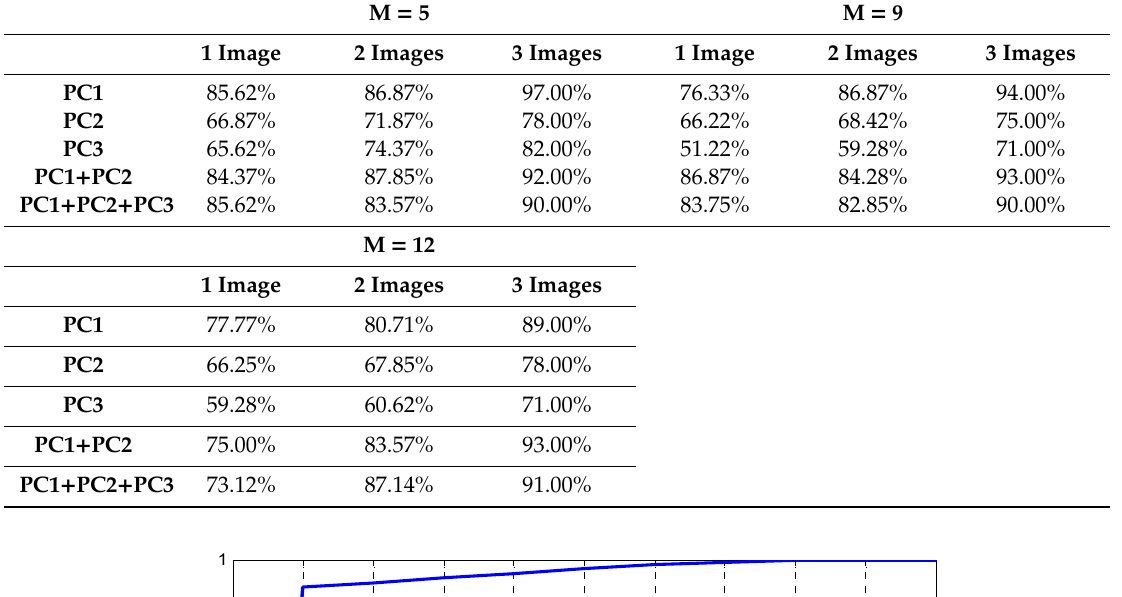
Table 3. Recognition rate of the face unimodal biometric system performed on the ORL face database.